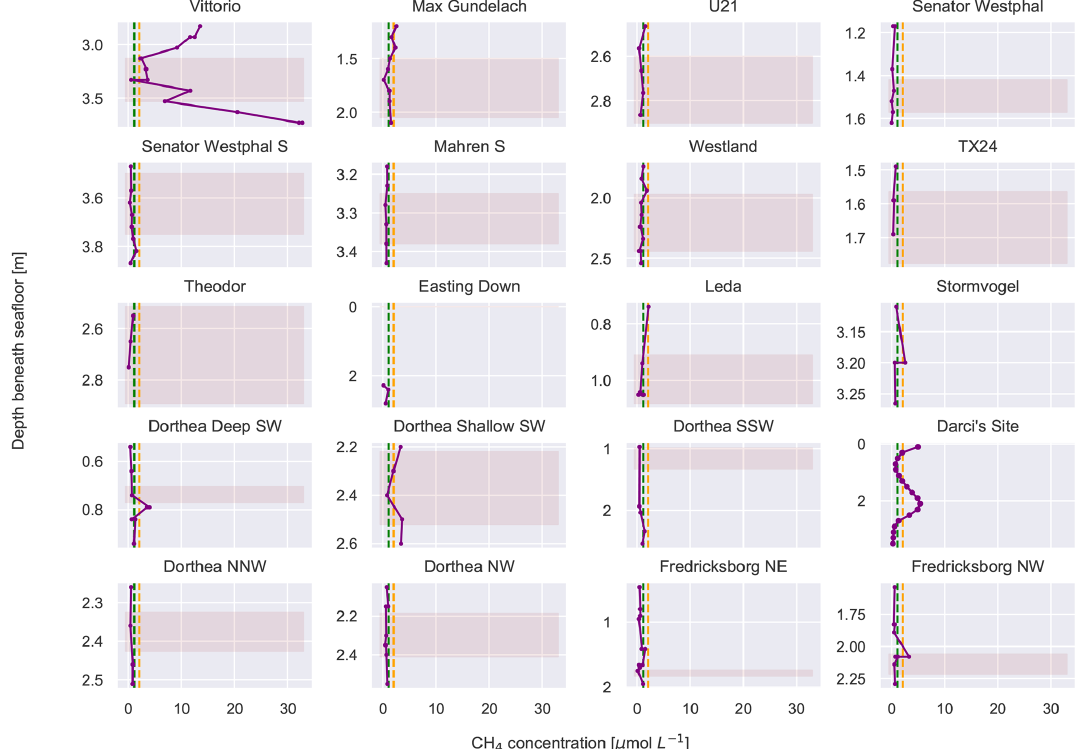
Figure 3. Depth profiles of methane concentrations at all sites (in µmolL − 1 ). The yellow line indicates the average methane concentration across all measurements. The green line indicates the average methane concentrations of seawater measured in the same area (Borges et al., 2016). The pink shaded regions are indicative of peat. Note the varying y